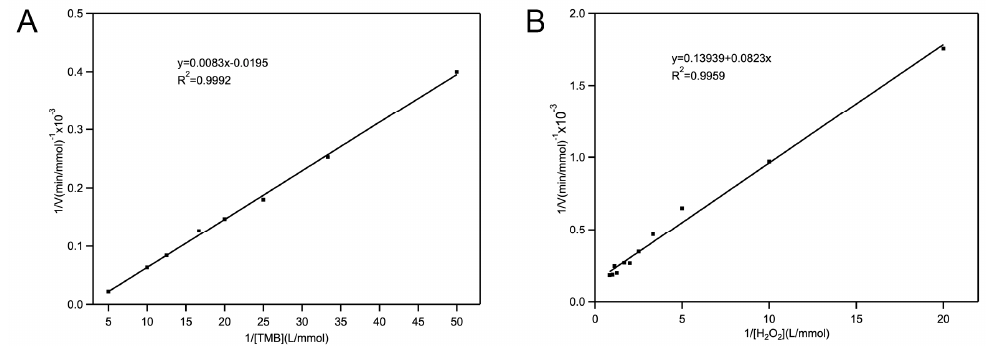
Table 1. Kinetic parameters for different POD-like activity .